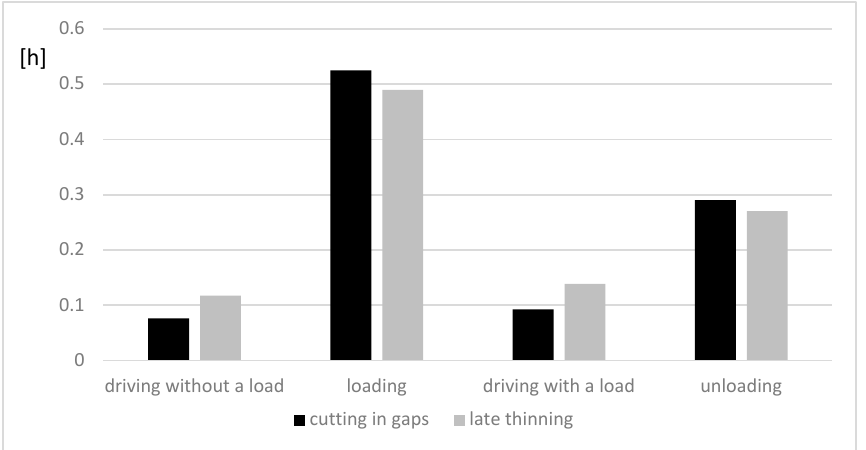
Figure 3. Time of individual transport operations in an average forwarding cycle.